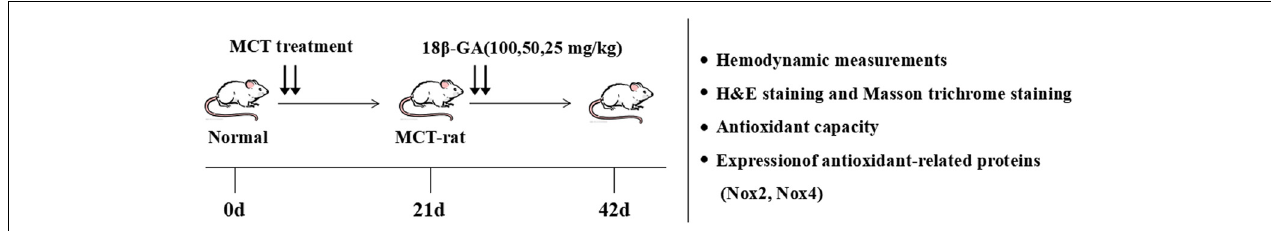
FIGURE 2 | Experimental design. PAH model of rats was established by single subcutaneous injection of MCT (60 mg/kg). After 21 days, 18 β -GA (100, 50, and 25 mg/kg/day) was intragastrically administered. At the end of the treatment, lung structure and function were evaluated through various experimental methods.